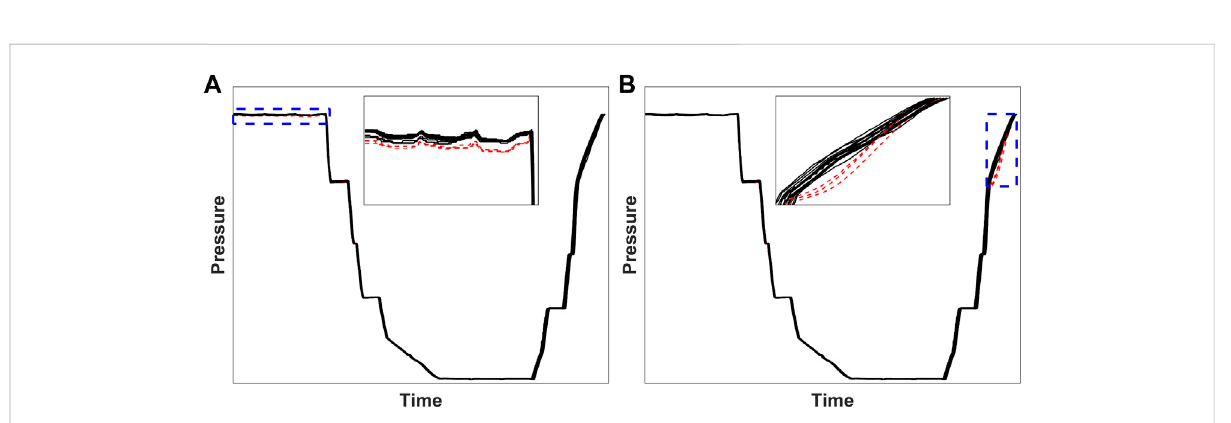
FIGURE 4 Pressuretrajectoriesoftheselectedtestsets (A) Faultscenario1 (B) Faultscenario5.Normalcyclesareplottedinblackwhilefaulty cyclesarein red. The steps in which the fault occurred are marked by blue dashed-line rectangles and shown in the zoom-in views.